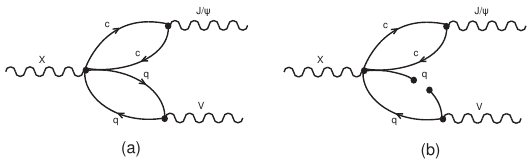
Fig. 4. Leading order diagrams which contribute to the X decay.